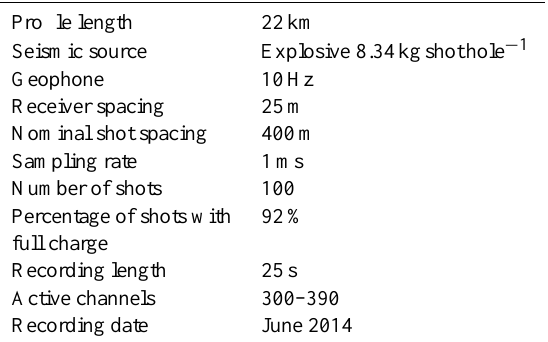
Table 1. Seismic acquisition parameters used during the seismic